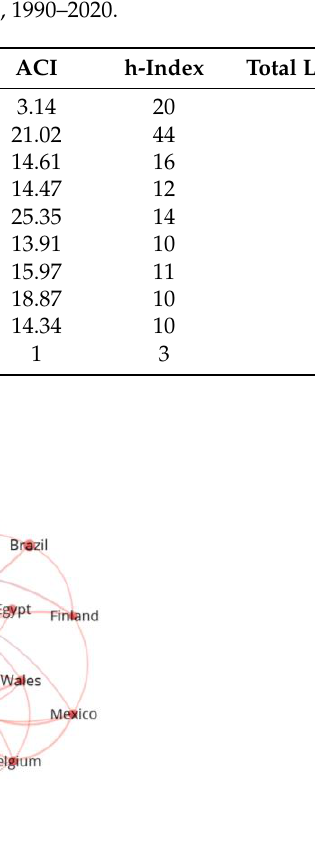
Table 2. Top 10 productive countries in NPO studies, 1990–2020.